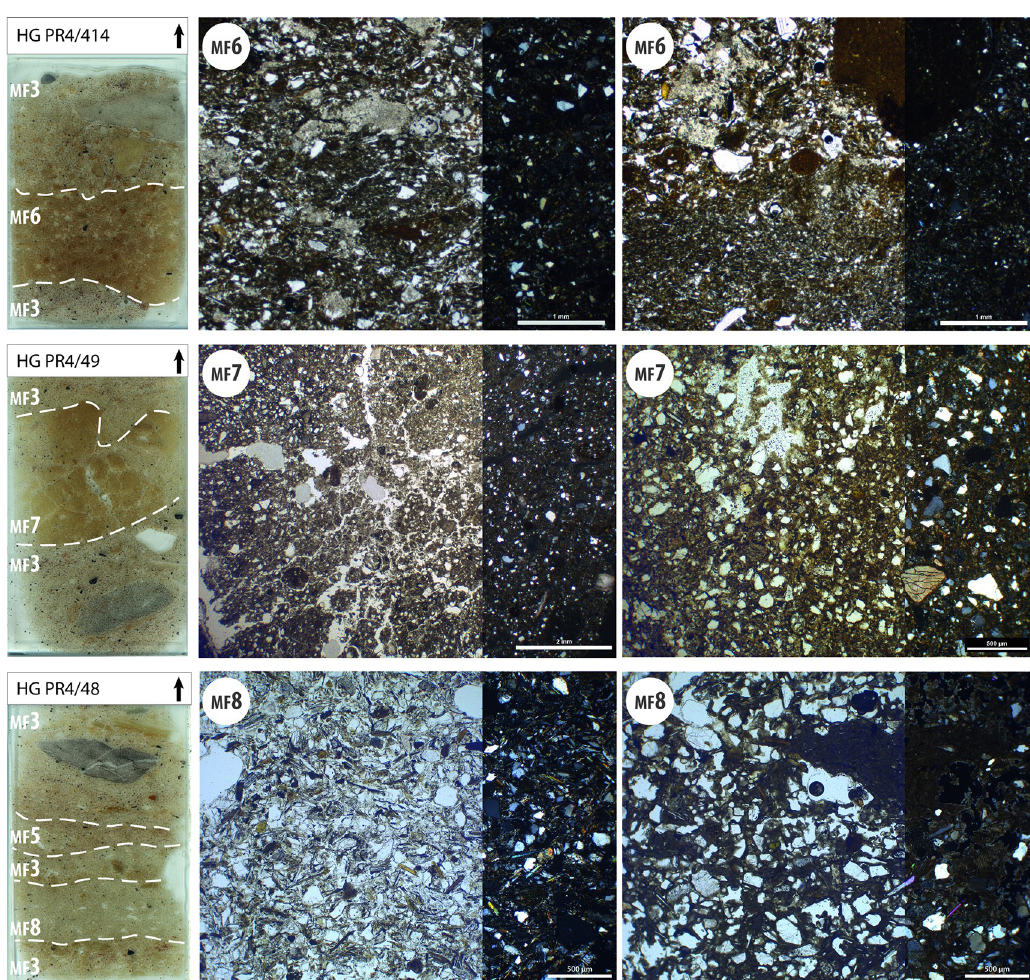
Fig 7. Scans and photomicrographs of thin-sections representing microfacies MF6 to MF8 related to earthen soils. Photomicrographs were taken both in in PPL (right two thirds of the image) and XPL (left one third of the image). The dashed lines represent the borders between MFs in each thin-section. These MFs were distinguished on the basis of the nature of the silty clayey matrix and of the coarse fraction. Note how the proportion of coarse and fine fraction is almost identical in MF6 and MF7, while the coarse fraction (made up of mica, quartz and gypsum grains) is dominant in MF8. MF6 soils show a sub-millimetric, rounded granular structure, while MF7 soils are massive, with larger angular and subangular aggregates produced by trampling and, probably, drying. MF8 soils are thinner, compact (i.e. less porous) and